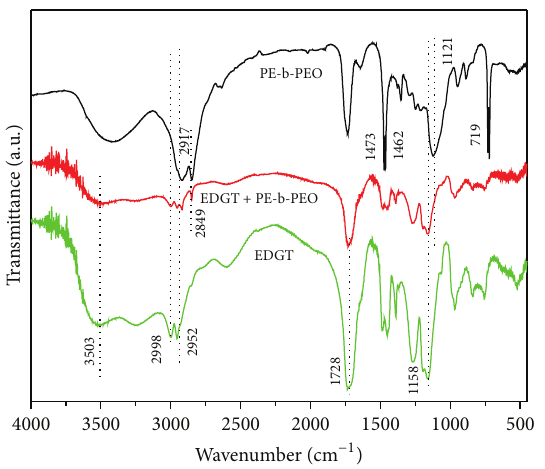
Figure 4: FTIR spectrum of pristine PE-b-PEO and electrospun fibers of Eudragit L-100 (EDGT) and Eudragit L-100 + PE-b-PEO (EDGT + PE-b-PEO).